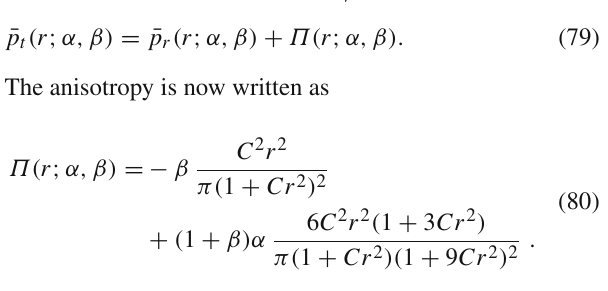
Fig. 4 Effective thermodynamic quantities for different values of the parameters { α,β } . The solid black line represents the standard Durgapal–Fuloria solution ( α = β = 0). The dashed red line is the anisotropic solution used as a seed { α = 0 . 3 ,β = 0 } . This configura-